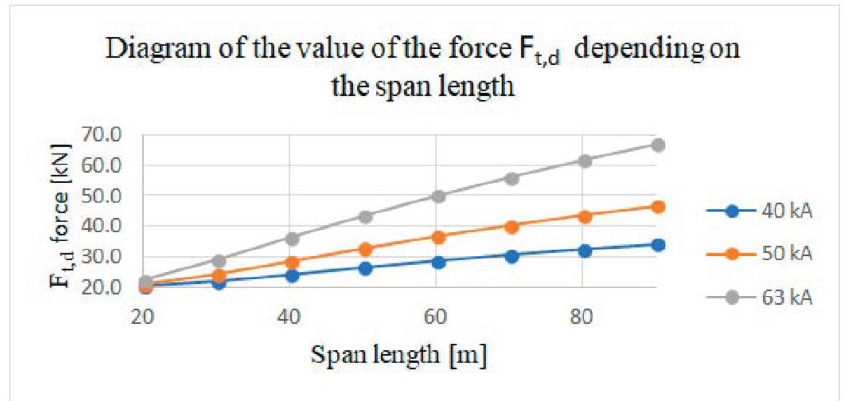
Figure 6. Graph of the value of the force F t,d depending on the span length.